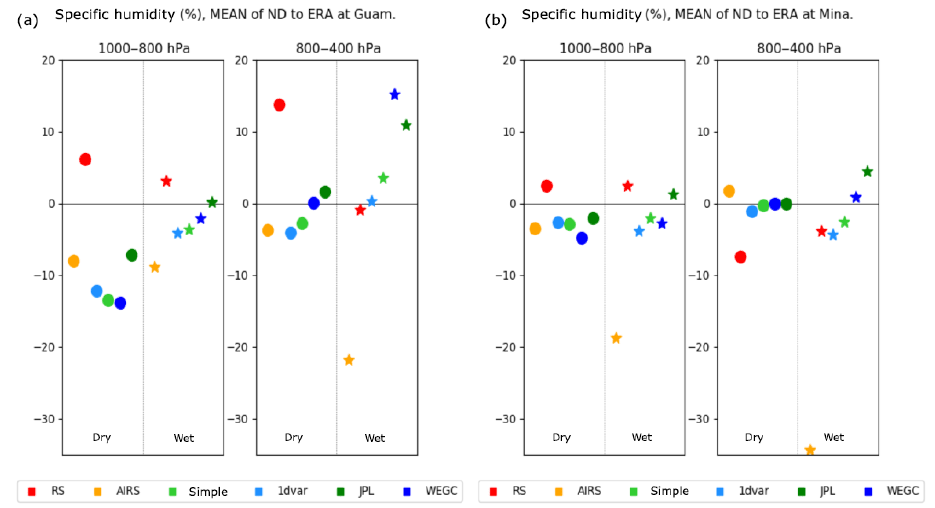
Figure 8. Mean differences for dry versus wet atmospheric conditions based on RH 800 − 400 at Guam (a) and Minamidaitojima (b) . The different colors represent the different data sets. Circles and stars represent the data sets for dry and wet conditions in the mid-troposphere,